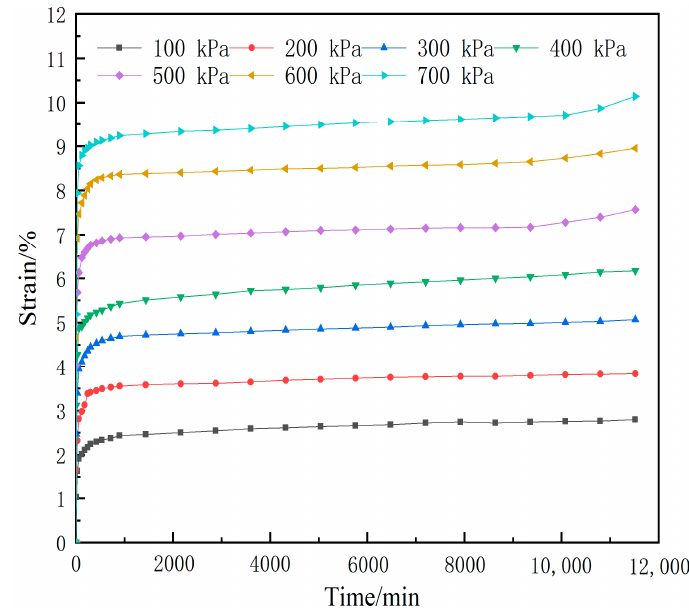
Figure 4. Strain–time curves of silty clay under different vertical loads. Figure 4. Strain – time curves of silty clay under di ff erent vertical loads. Table 5. Test results of silty clay.